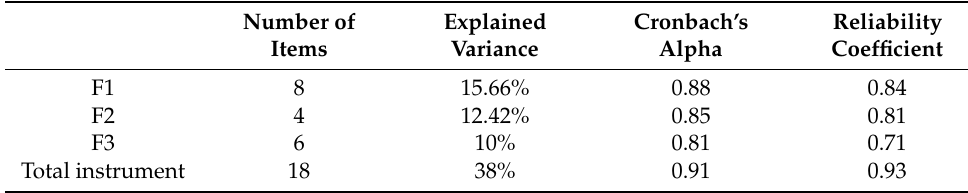
Table A2. Confirmatory Factorial Analysis